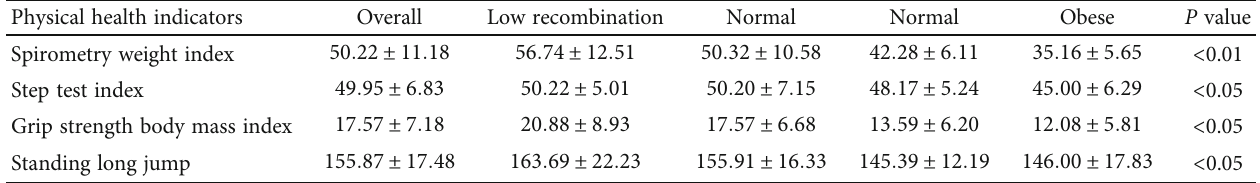
Table 2: Statistical analysis of physical health indicators of female students and signi fi cance test of BMI and each physical health indicator. Physical health indicators